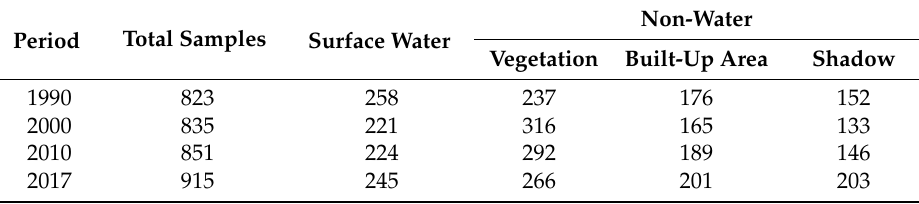
Table 2. Detail information of reference